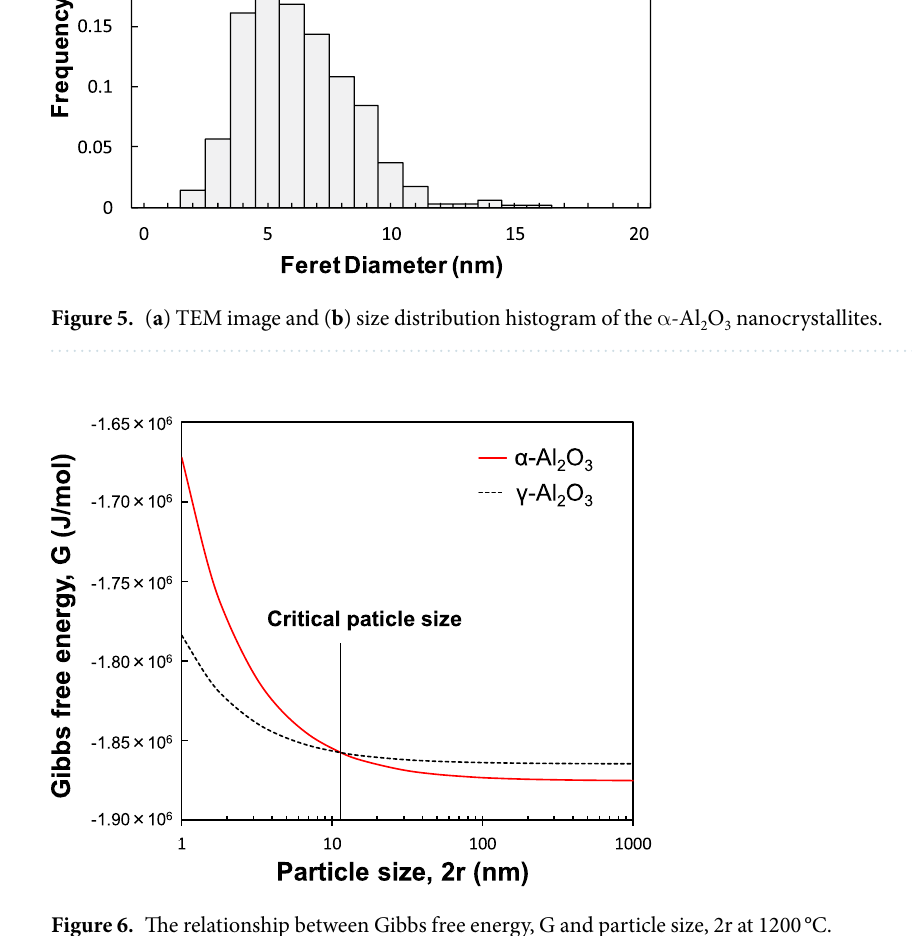
the thermal decomposition of the aluminum formate hydroxide had lower activation barrier to form α -Al 2 O 3 phase than that of the transition phases, and resulted in the nucleation of α -Al 2 O 3 with the size under 10 nm. On the other hand, the crystallite size of α -Al 2 O 3 obtained by Scherrer equation in Fig. 2(a) for 50 s was 38.7 nm which was larger than the estimated critical diameter of 11 nm in the nucleation from the transition phase in Fig. 6. Considering the estimation of crystallite size in XRD, it is not sure whether the amorphous phase has the lower activation barrier to form α -Al 2 O 3 than the transition phases. We do not have the valid explanation of this discrepancy between TEM micrograph and XRD in crystallite size. The careful discussion is needed to clarify the critical particle size of α -Al 2 O 3 during the rapid heating of this precursor powder. Figure 7 shows the schematic images of the microstructural evolution during the formation of the rod-like α -Al 2 O 3 . The agglomerations of the aluminum formate hydroxide particles were thermally decomposed to